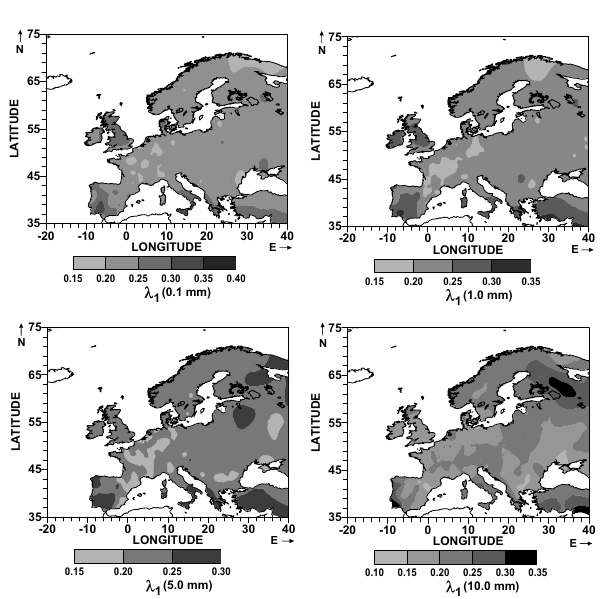
Fig. 11. Spatial distribution of the first positive Lyapunov exponent for thresholds of 0.1, 1.0, 5.0 and 10.0mm/day.